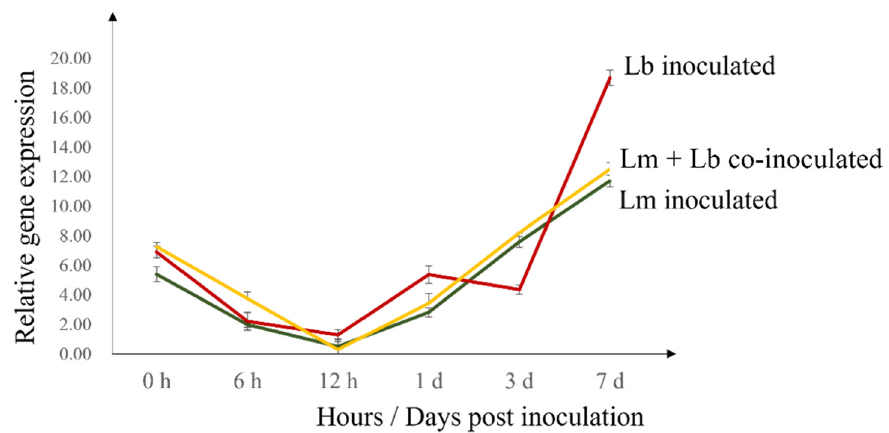
Figure 5. Expression profile of RbohD in Westar cotyledons infected with LmGFP, LbDsRed as sole and combined inocula. RbohD expression was upregulated at an exponential rate from 3- to 7- dpi. The observations were taken at 0-, 6-, 12- hpi and 1-, 3-, 7- dpi.